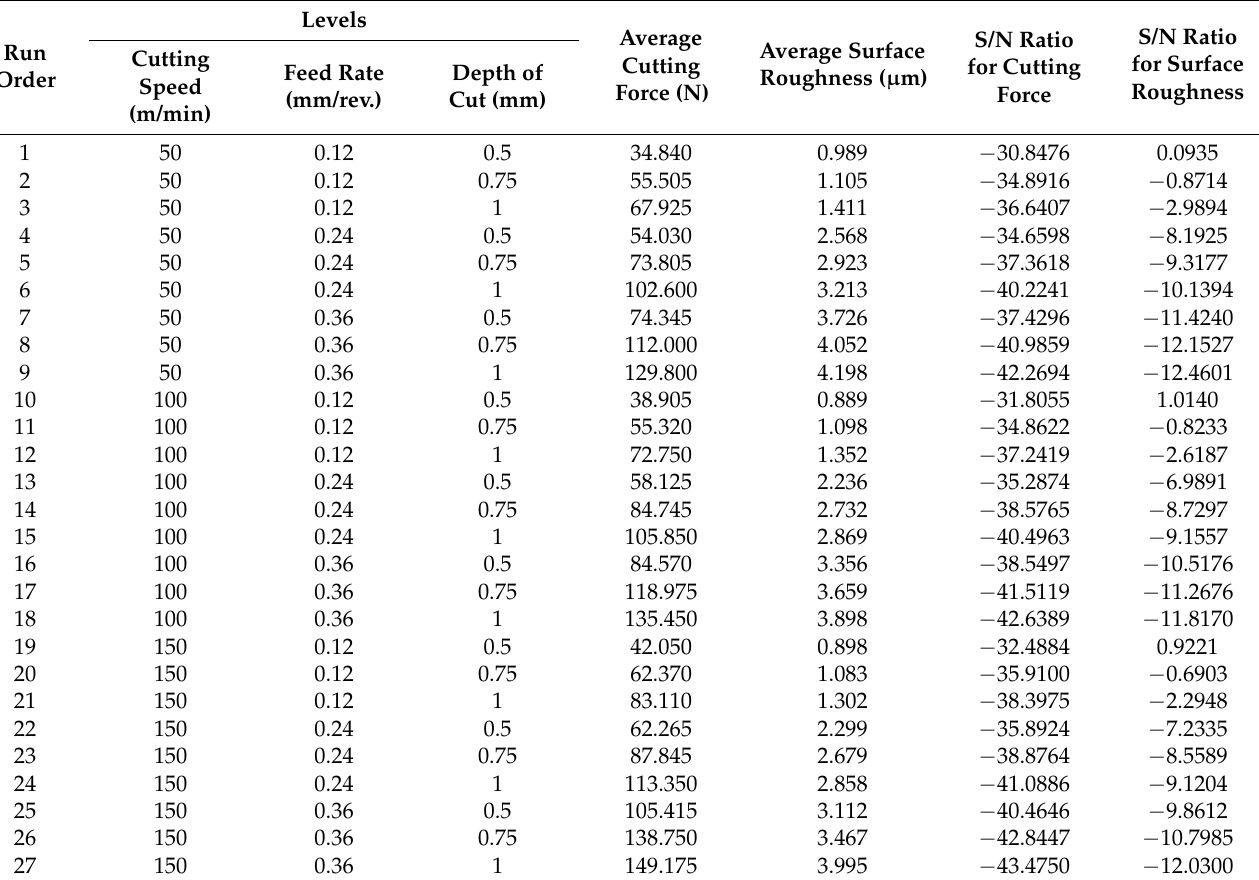
Table 2. Experimental results for the machinability of the RZ5/8 wt.% TiB 2 composite and the S/N